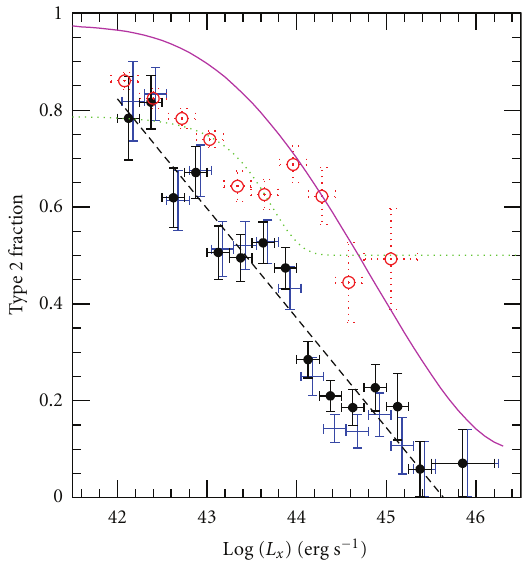
Figure 8: Fraction of type 2 AGN as a function of X-ray luminosity (from Hasinger [135]). The solid symbols show hard X-ray-selected AGN (blue and black symbols illustrate di ff erent subsamples in terms of redshift completeness). The red-dotted symbols show optically selected AGN (from Simpson [131]). The magenta line shows the type 2 fraction inferred from the dust covering factor obtained through near/mid-IR observations (from Maiolino et al. [139], note that these include also Compton-thick AGN, which are not present in X-ray samples). The green-dotted line shows the expected fraction of Compton-thin type 2 AGN according to the X-ray background synthesis models given in Gilli et al.